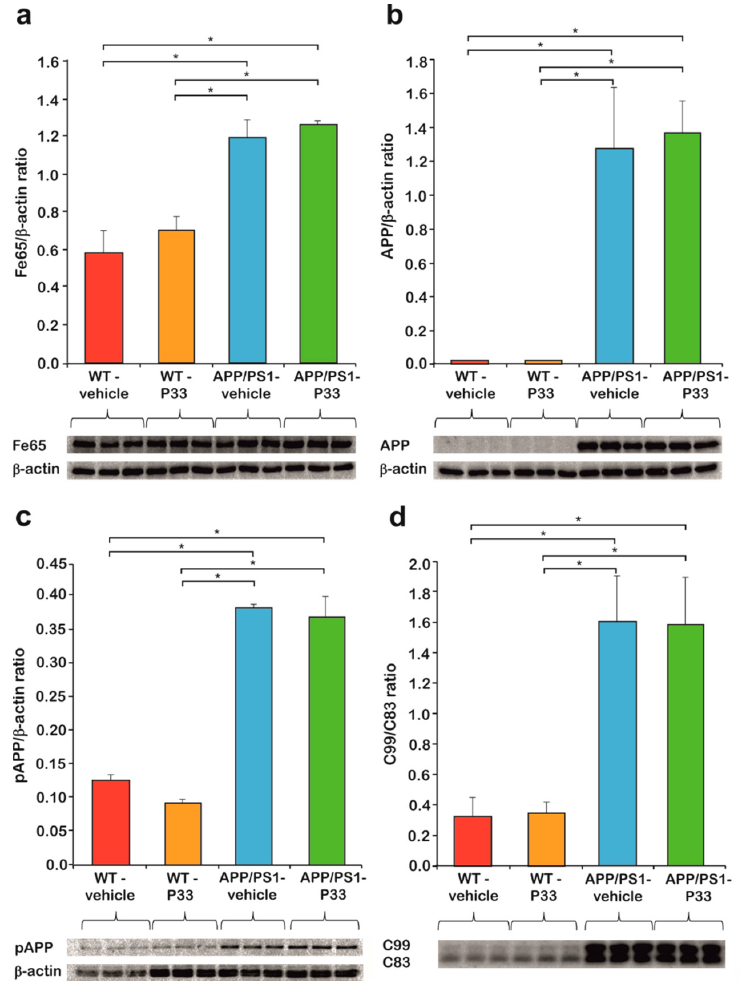
Figure 4. Western blot (WB) analysis of Fe65, amyloid precursor protein (APP), pThr 668 -APP, C83, and C99 levels. ( a ) Fe65 level of the APP/PS1 mice is significantly higher than in the wild-type (WT) animals, which did not change upon P33-treatment (* represents significant differences at the following p -levels: H 3,8 = 5.702, p = 0.022; APP/PS1-vehicle vs. WT-vehicle, WT-P33 p = 0.001,